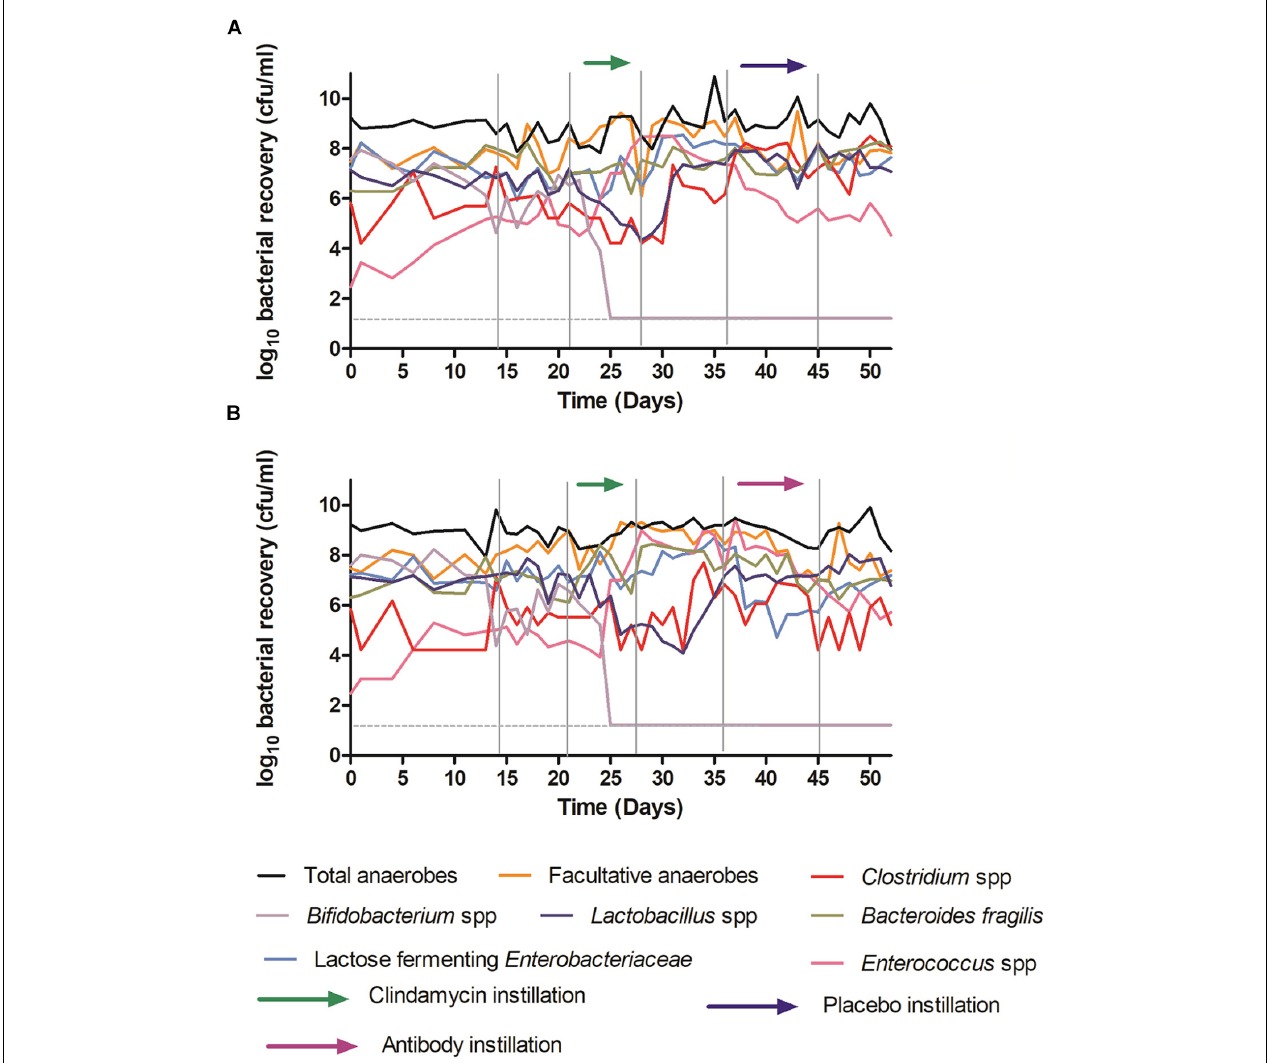
FIGURE 7 | Mean viable counts of selected microbiota communities in vessel three of the in vitro gut model. (A) – Model 1 (placebo); (B) – Model 2 (antibodies). The limit of detection is 1.22 log 10 cfu/ml; horizontal dotted